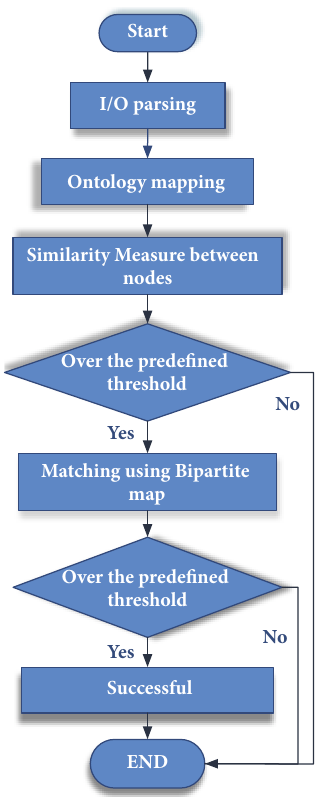
Figure 4: I/O-level functional